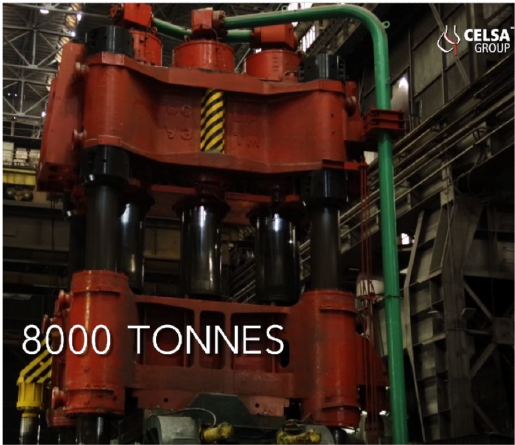
Figure 1: Industrial 80 MN (8000 T) hydraulic press for hot open die forging (photo source